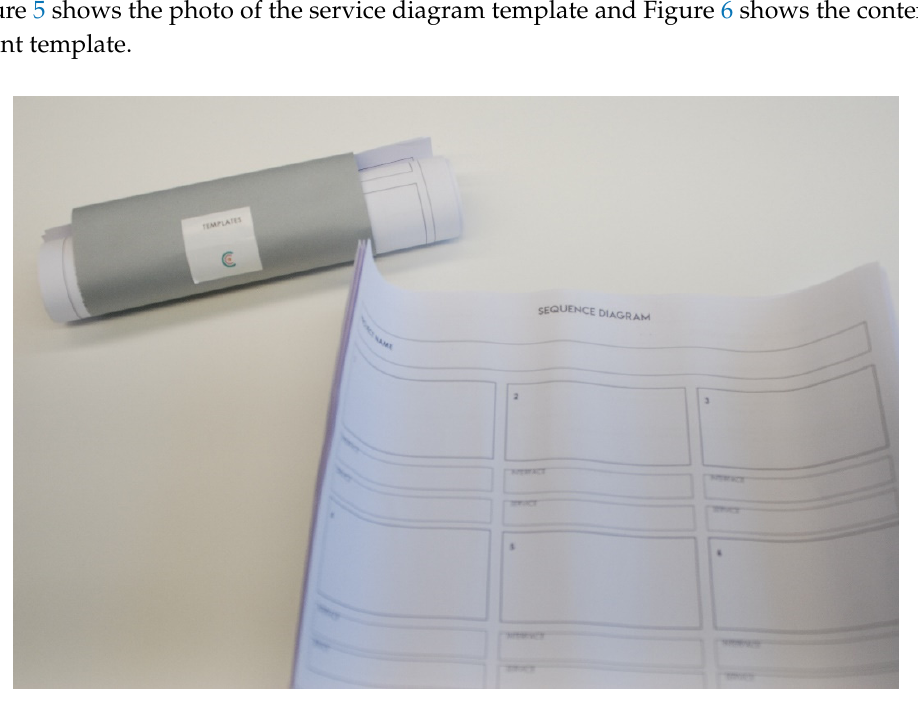
Figure 5. Service Diagram Template.